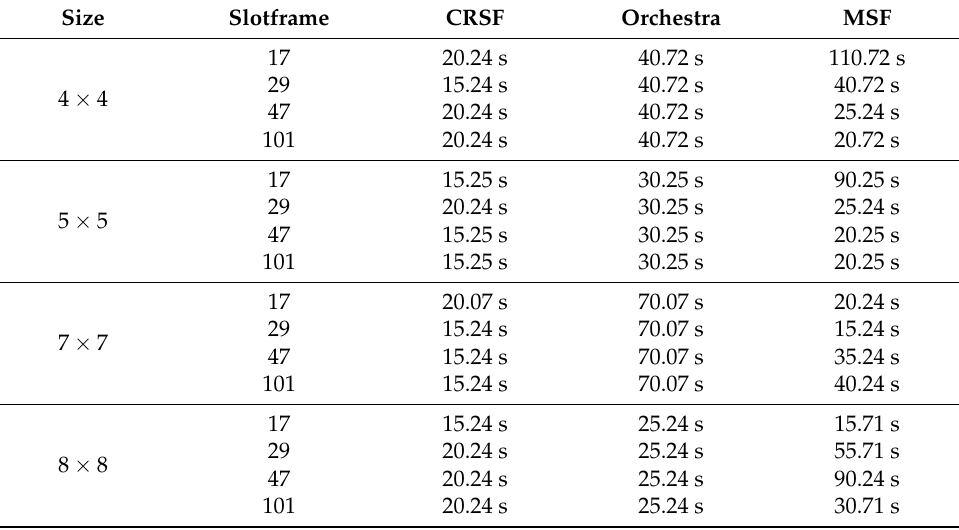
Table A4. Results for first packet reception (in seconds) with a periodic traffic